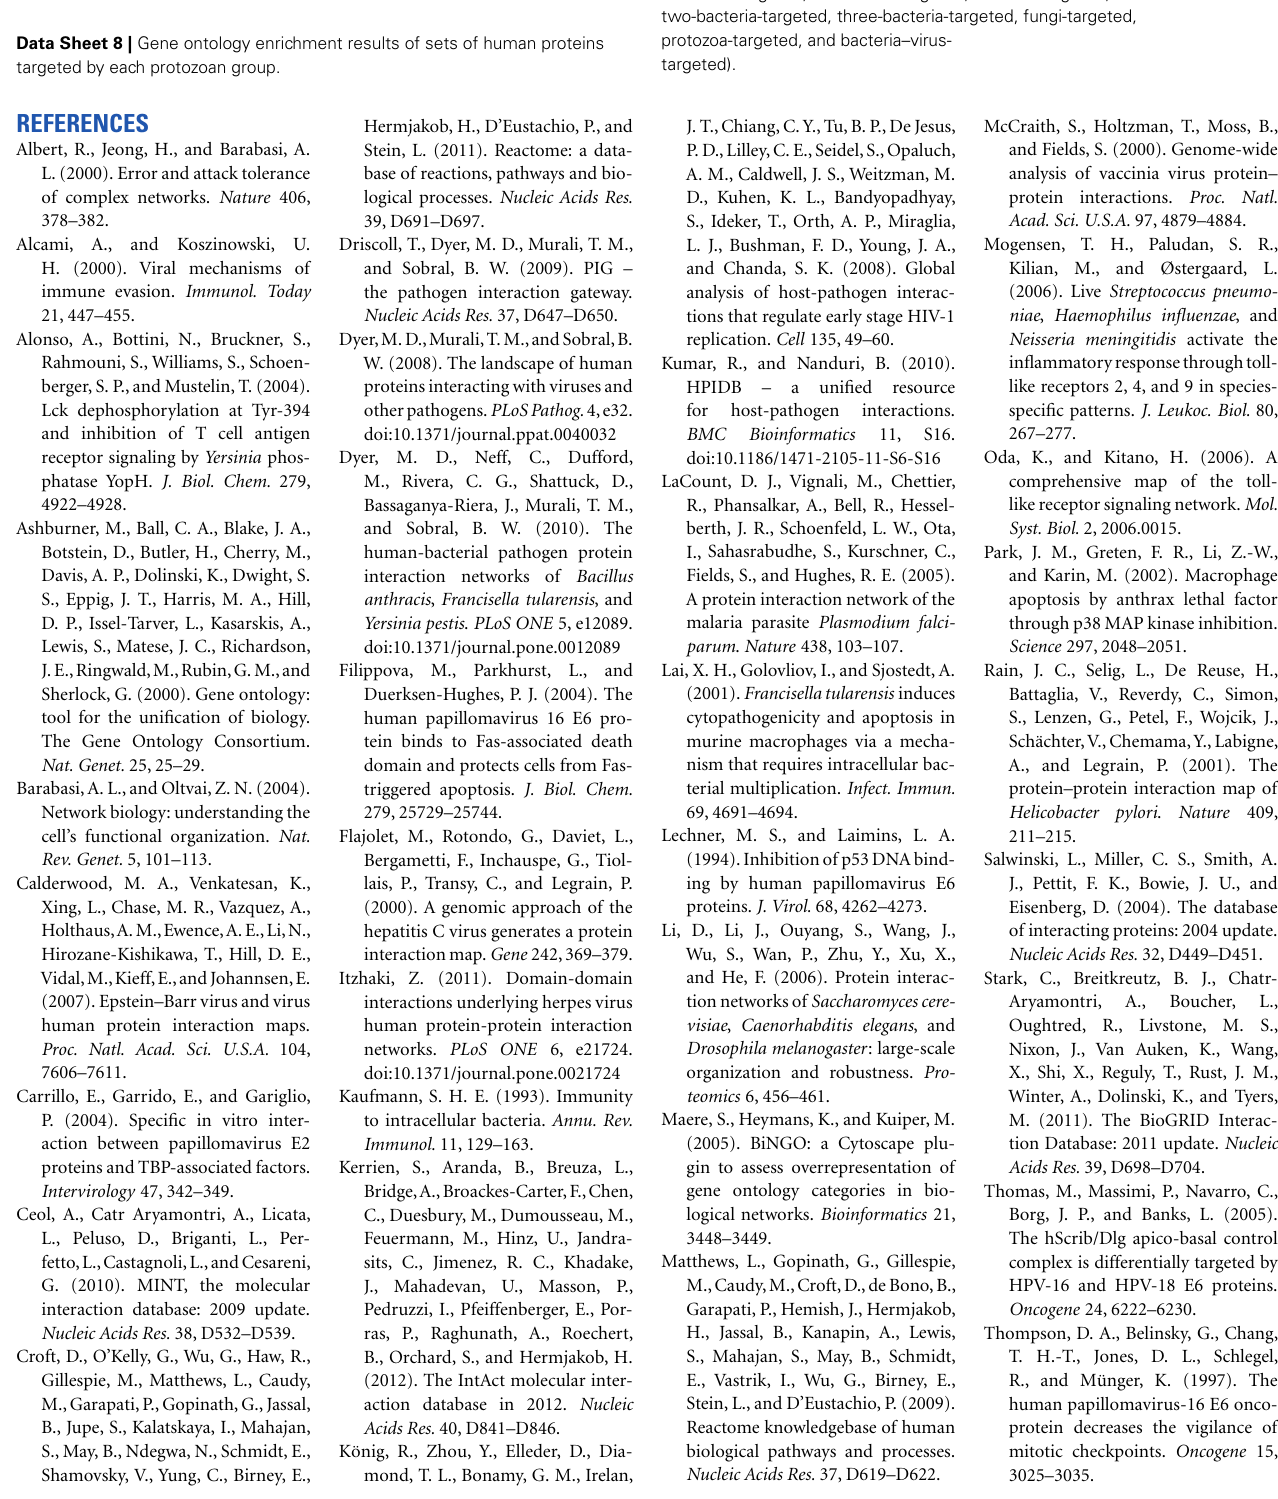
Data Sheet 9 | Gene ontology enrichment results of sets of human proteins targeted by each viral group. Data Sheet 10 | Gene ontology enrichment results of other sets of human proteins (pathogen-targeted, virus-targeted, two-virus-targeted, three-virus-targeted, bacteria-targeted, two-bacteria-targeted, three-bacteria-targeted, fungi-targeted, protozoa-targeted, and bacteria–virus-